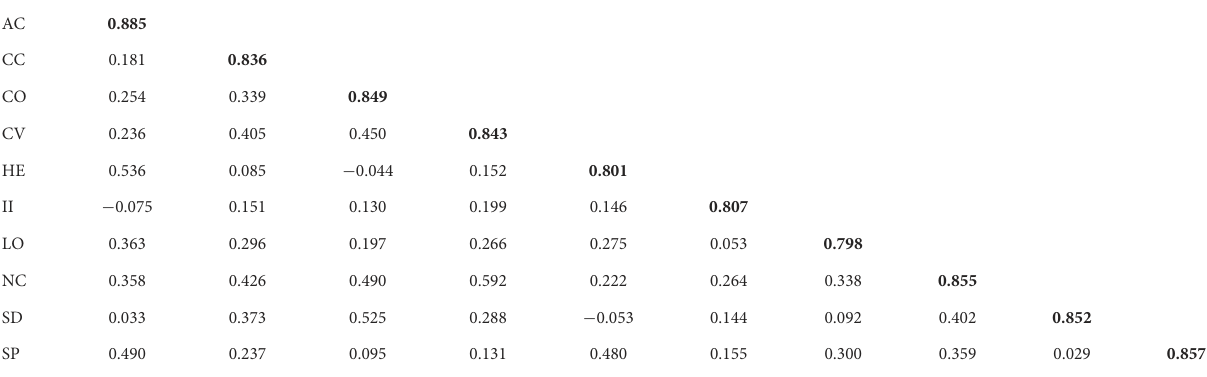
TABLE 3 Result of the discriminant